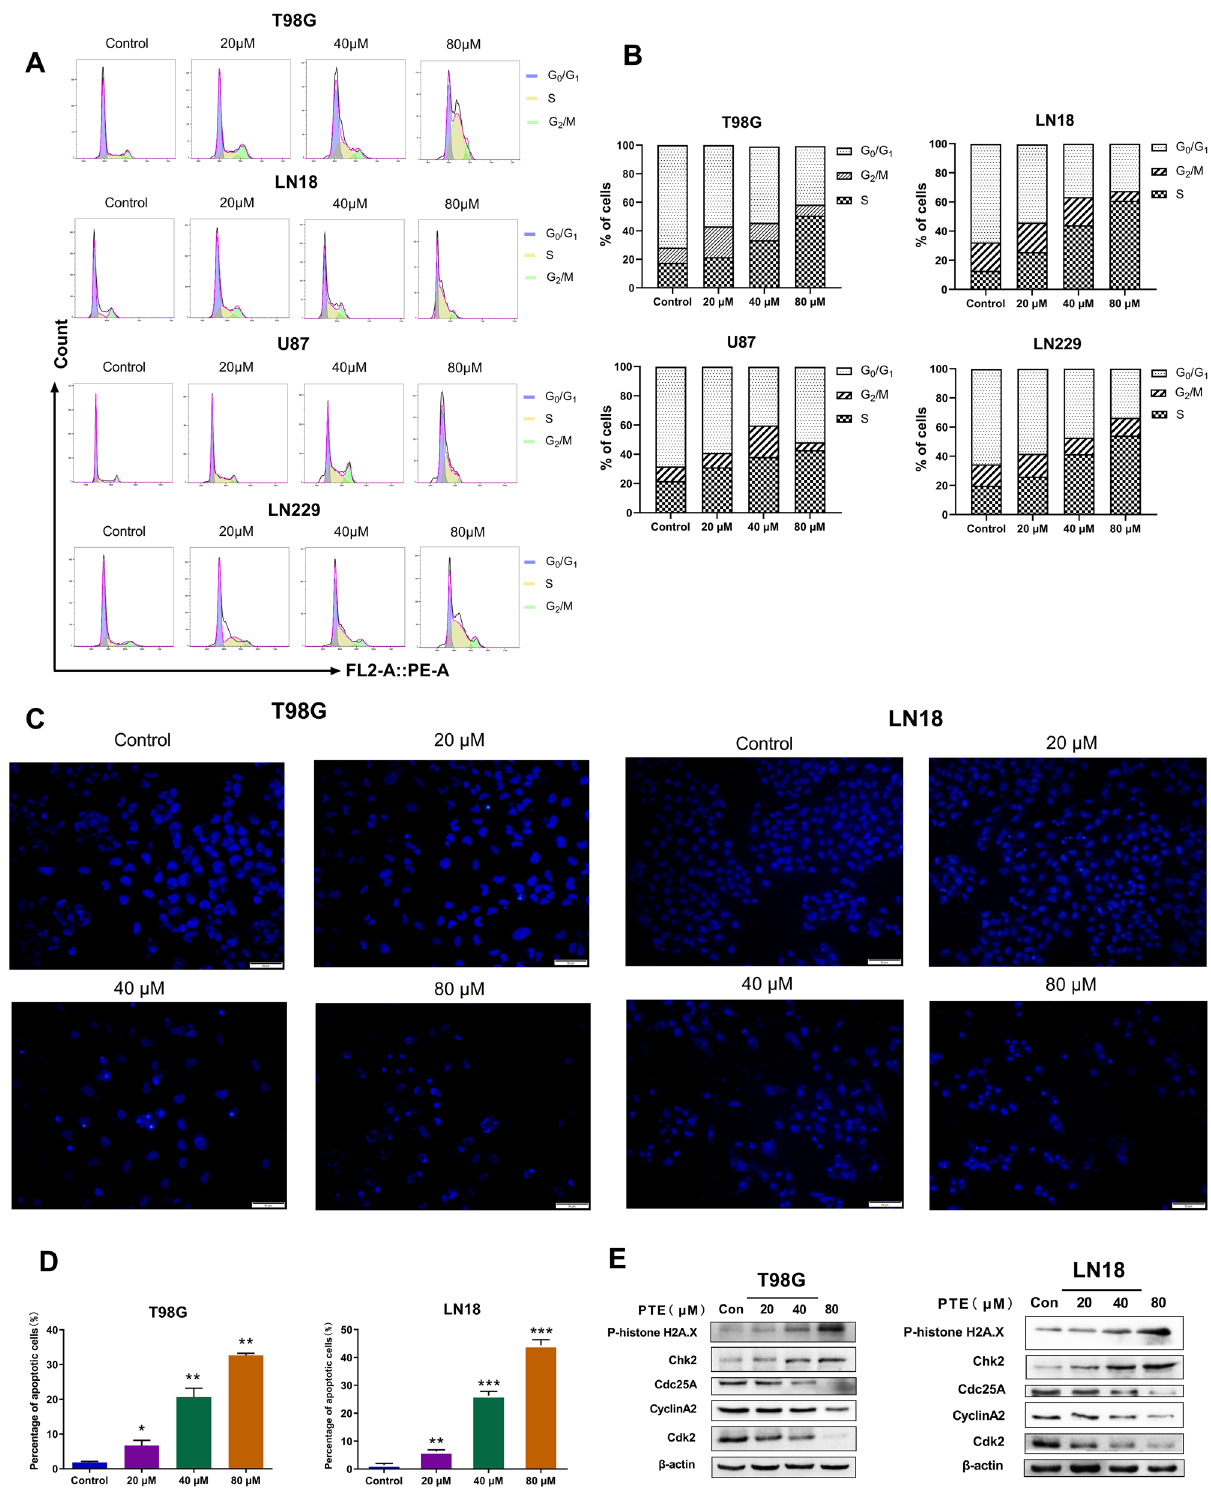
Figure 3. Pterostilbene induces S phase cell cycle arrest in glioma cell lines. ( A ) T98G, LN18, U87 and LN229 glioma cells were treated with PTE (0, 20, 40 and 80 µM) for 48 h followed by propidium iodide staining and cell cycle distribution was analyzed by flow cytometry. ( B ) Histograms showed the percentage of T98G, LN18, U87 and LN229 glioma cells in G 0 -G 1 , S, and G 2 phases. ( C )T98G and LN18 cells were treated with PTE (0, 20, 40, 80 µM) for 48 h before staining with 10 mg/L Hoechst 33342. The representative images under a fluorescence microscope (20 ×) showed the Morphological changes. ( D ) Percentages of apoptotic cells in PTE-treated T98G and LN18 cells were analyzed. ( E ) The levels of cell cycle-associated protein expressions (phospho-Histone H2A.X, cdc25A, CDK2, Chk2 and Cyclin A2) were analyzed by western blotting following exposure with PTE for 48 h in T98G and LN18 cells. β-actin was used as a loading control. Data are presented as the mean ± standard deviation (SD); n = 3; * p < 0.05, ** p < 0.01 and *** p < 0.001, compared with the vehicle control